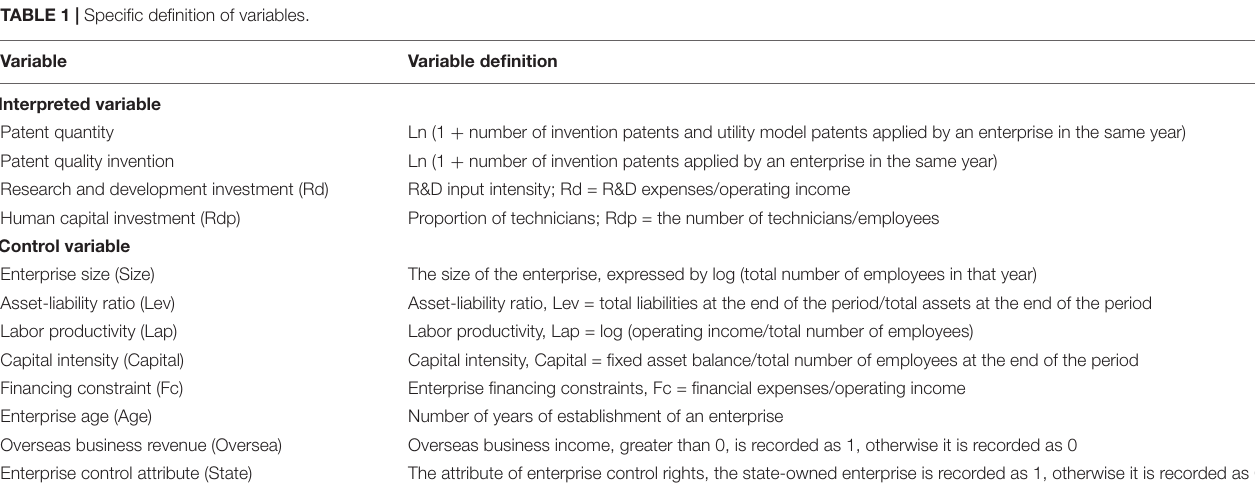
FIGURE 1 | Overseas M&A of Chinese enterprises from 2008 to 2018. Data obtained from enterprise patent database in wind. TABLE 1 | Specific definition of